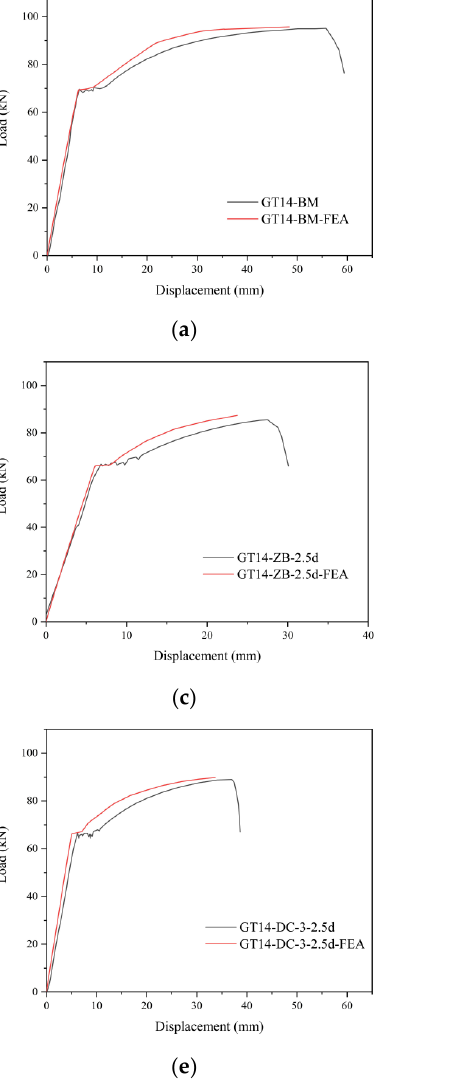
Figure 19. Load–displacement curves. ( a ) GT14-BM. ( b ) GT14-DB-3 d . ( c ) GT14-ZB-2.5 d . ( d ) Figure 19. Load – displacement curves. ( a ) GT14-BM. ( b ) GT14-DB-3 d. ( c ) GT14-ZB-2.5 d. ( d ) GT14-